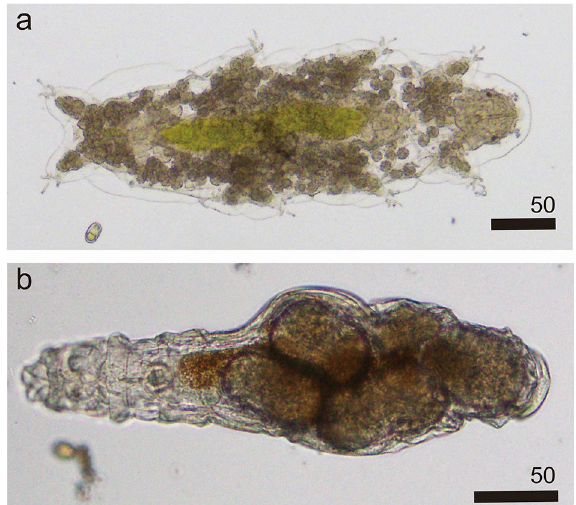
Figure 4. Microinvertebrates present in green snow collected in 2019. ( a ) Hypsibius sp. full of green pigment (digested algae) in their intestine (LM), ( b ) Philodina sp. (LM). All scale bars in micrometers.